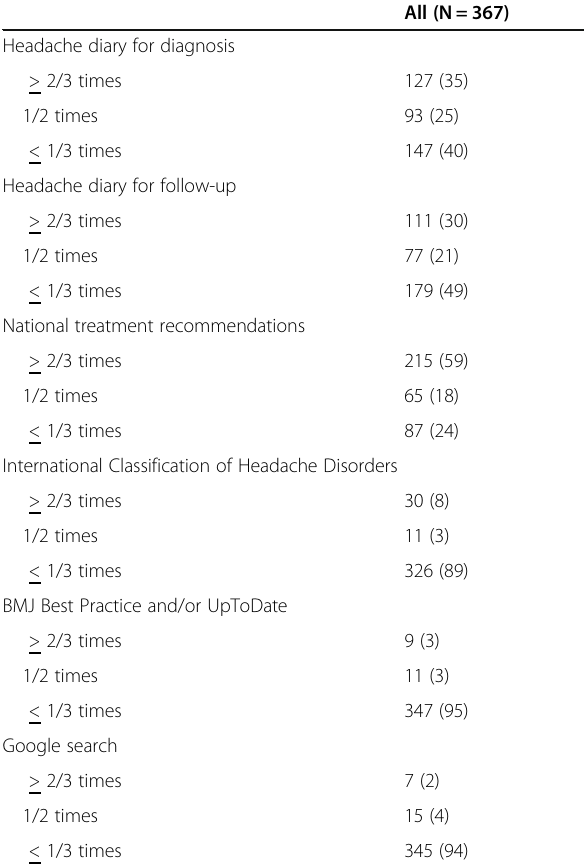
tools for diagnosis and follow-up of headache patients.